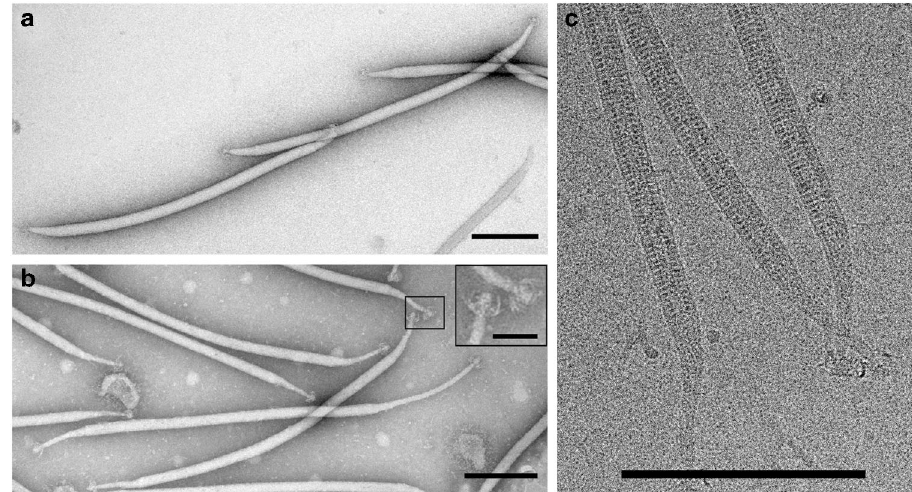
Fig. 1 Electron micrographs of SFV1 virions. a Negatively stained puri fi ed virions. b Negatively stained virions with an elongated “ neck; ” mop-like terminal structures are shown in the inset. c Cryo-EM of SFV1. Scale bars, 200 nm (50 nm in the inset, b